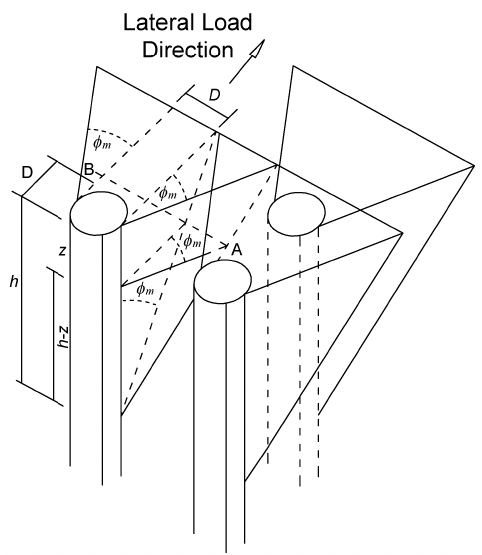
Figure 4. Mobilized soil passive wedges and pile-group interaction scheme (similarly as described in the context of the so-called Strain Wedge Model [34,35]).